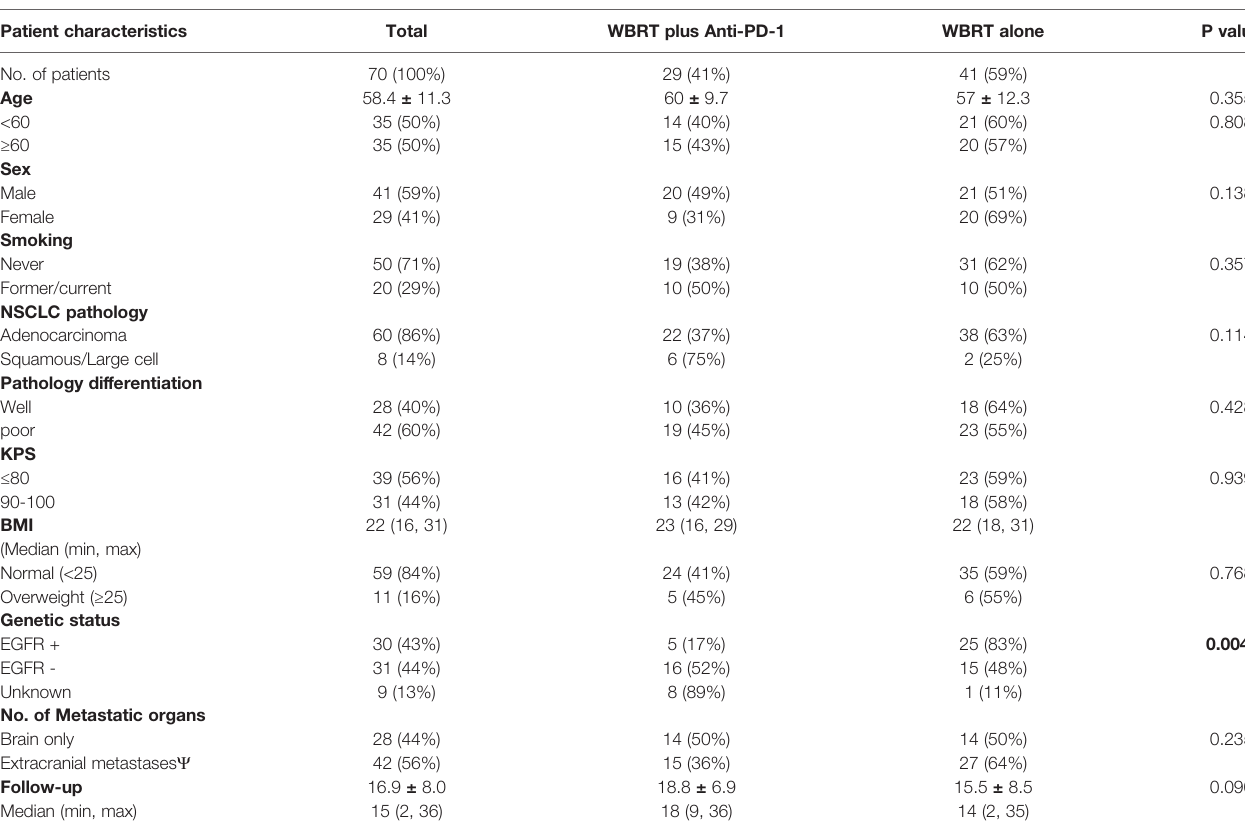
TABLE 1 | Baseline characteristics of included